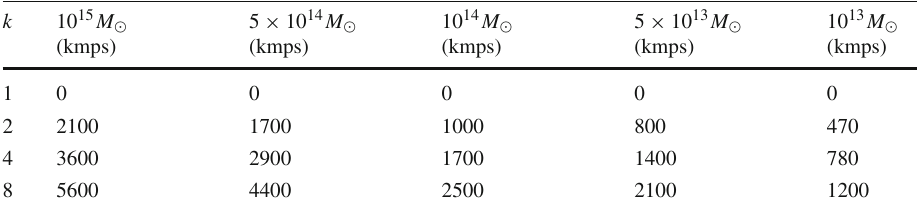
relative collision speeds in relation to the collision’s kinetic parameter k and the collision’s total mass M